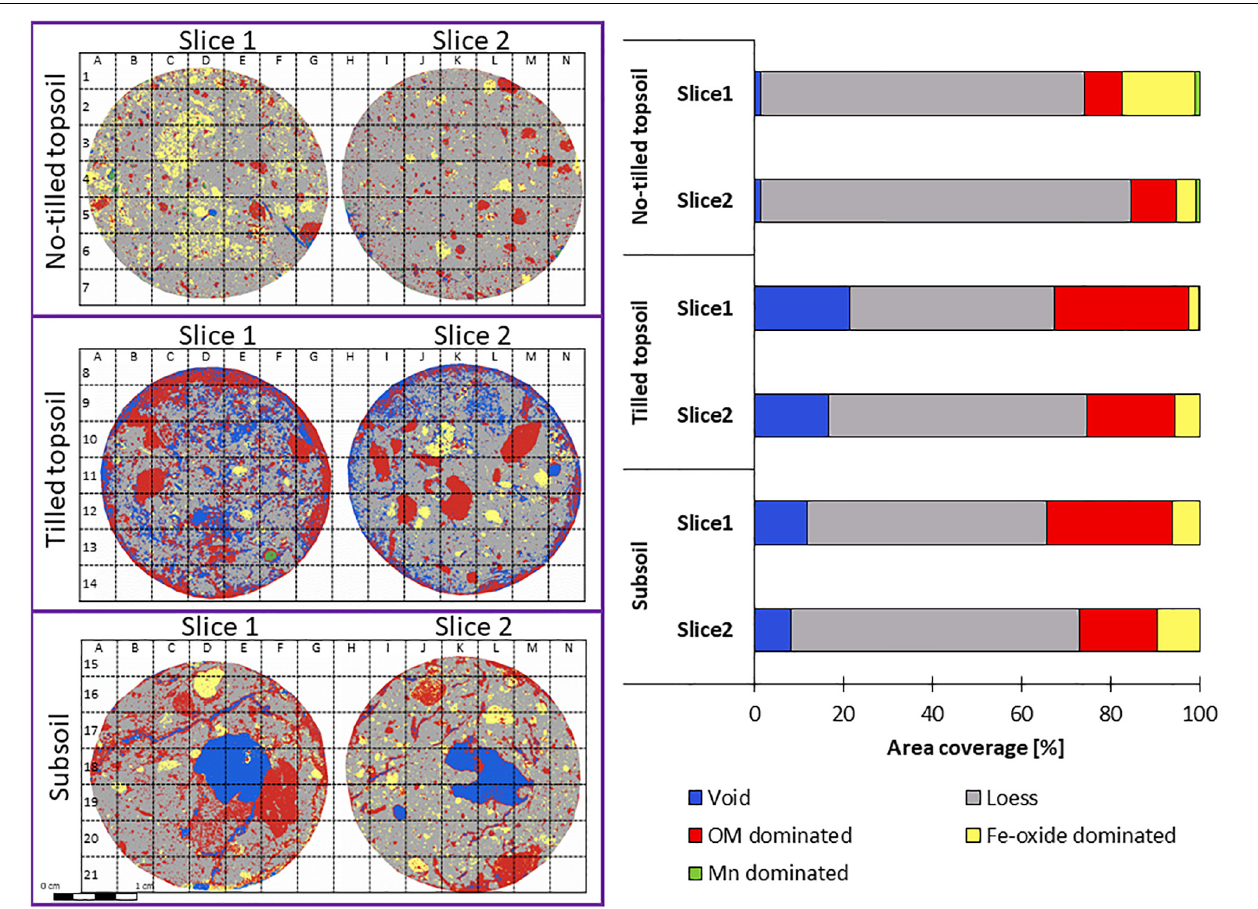
FIGURE 3 | Classification images and relative coverage of each class. Classification was computed on images of linear spectral unmixing (LSU). LSU images contain information about each endmember contribution to each pixel in the 2D space. When we classify images according to their abundancy, classes are calculated based on the highest domination of selected component. It means that for example a pixel classified as Fe is dominated by iron, but may also contain fractions of other endmembers.